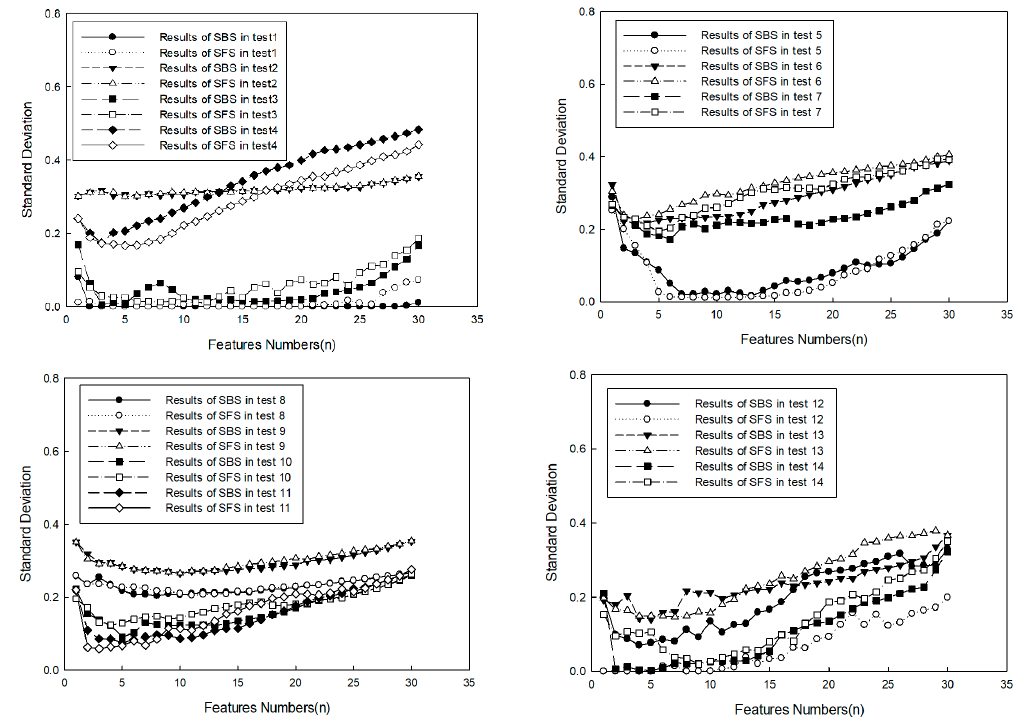
Figure 5. Selected experiment targets: ( a ) first target, pontoon; ( b ) second target, cube; ( c ) third target, triangular prism; ( d ) fourth target, reflector; and ( e ) fifth target, sphere.